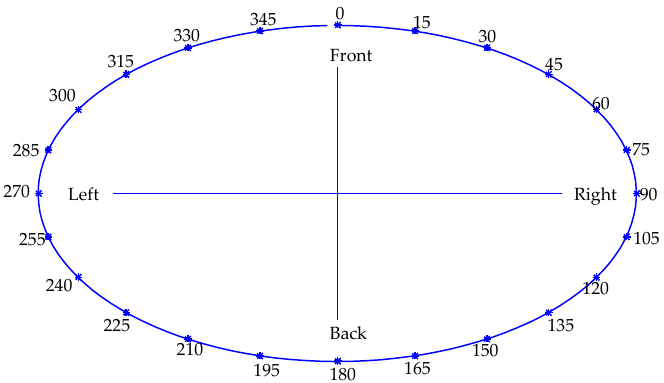
Figure 10. Testing azimuths in the experiment for Discrimination Degree of Given Azimuths.